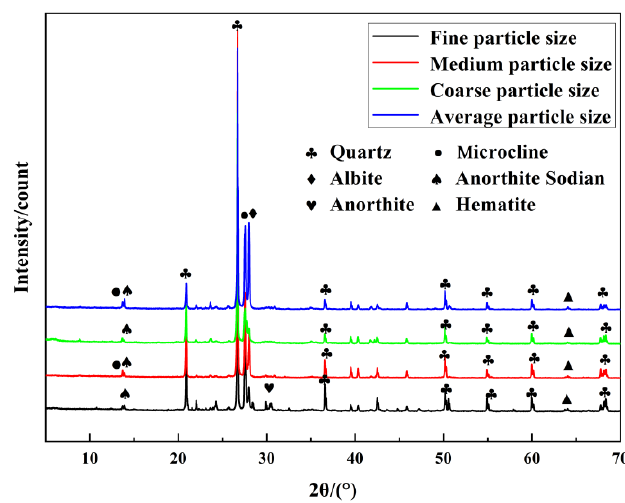
Figure 12. X-ray diffraction patterns of Xiaoluan river sediment.